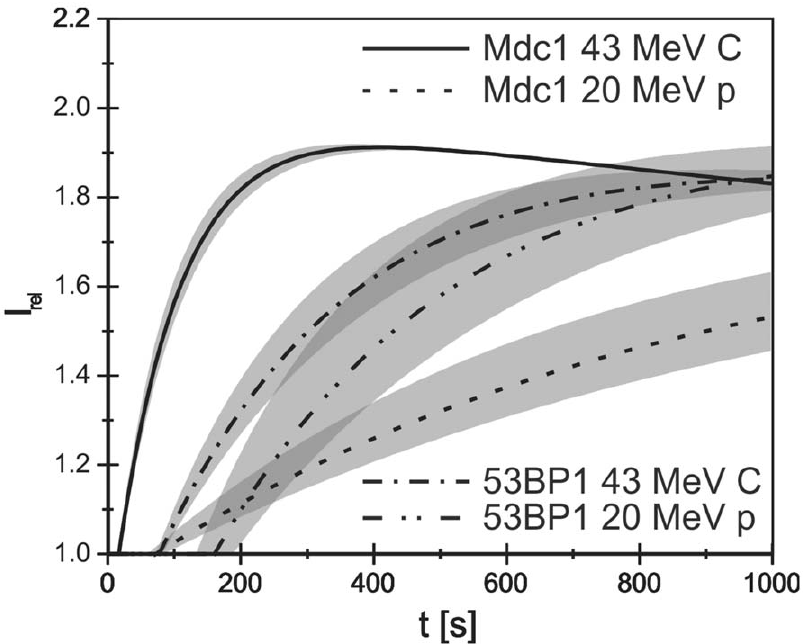
Figure 5. Comparison of the kinetics of Mdc1 and 53BP1 after carbon and proton irradiation. The shaded areas show the 1 s error bands for the fit functions. A strong LET dependency of Mdc1 is visible. For 53BP1 only the time lag after which foci formation starts shifts from high LET to low LET. The models are based on data obtained after irradiation of U2OS pEGFP-Mdc1 clone F1 with 5.2 Gy carbon ions or 4.8 Gy protons, and Hela pMC16-53BP1-GFP clone # 5 with 7.6 Gy carbon ions or 6.9 Gy protons, respectively.